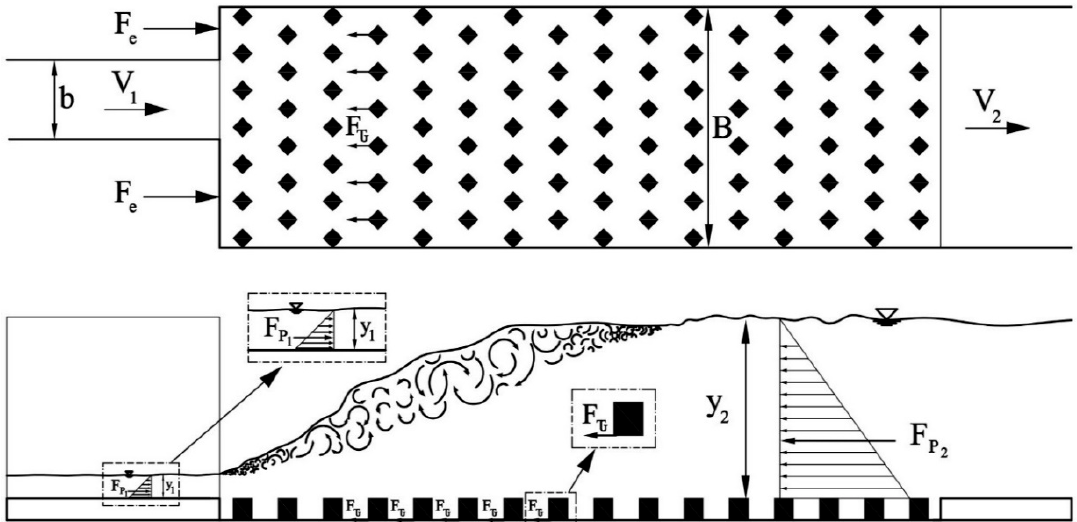
Figure 5. Schematic sketch of applying momentum equation for the hydraulic jump in abrupt asymmetric expanded channel on rough bed.